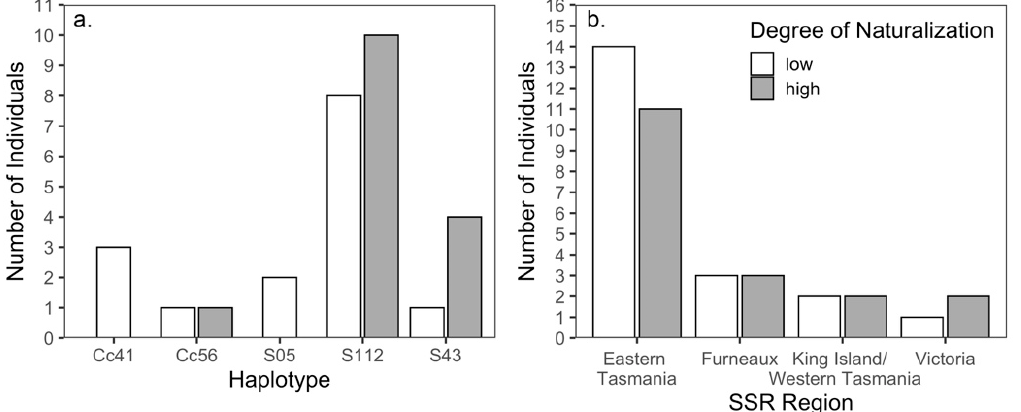
Figure 5. The number of individuals in sites classified as having low and high levels of naturalization by ( a ) cpDNA haplotype and ( b ) SSR region of origin assignment. The degree of naturalization was classified as high (naturalization scores of 3 and above) and low (scores of 2 and below). The SSR regions of origin are indicated in Figure 3.